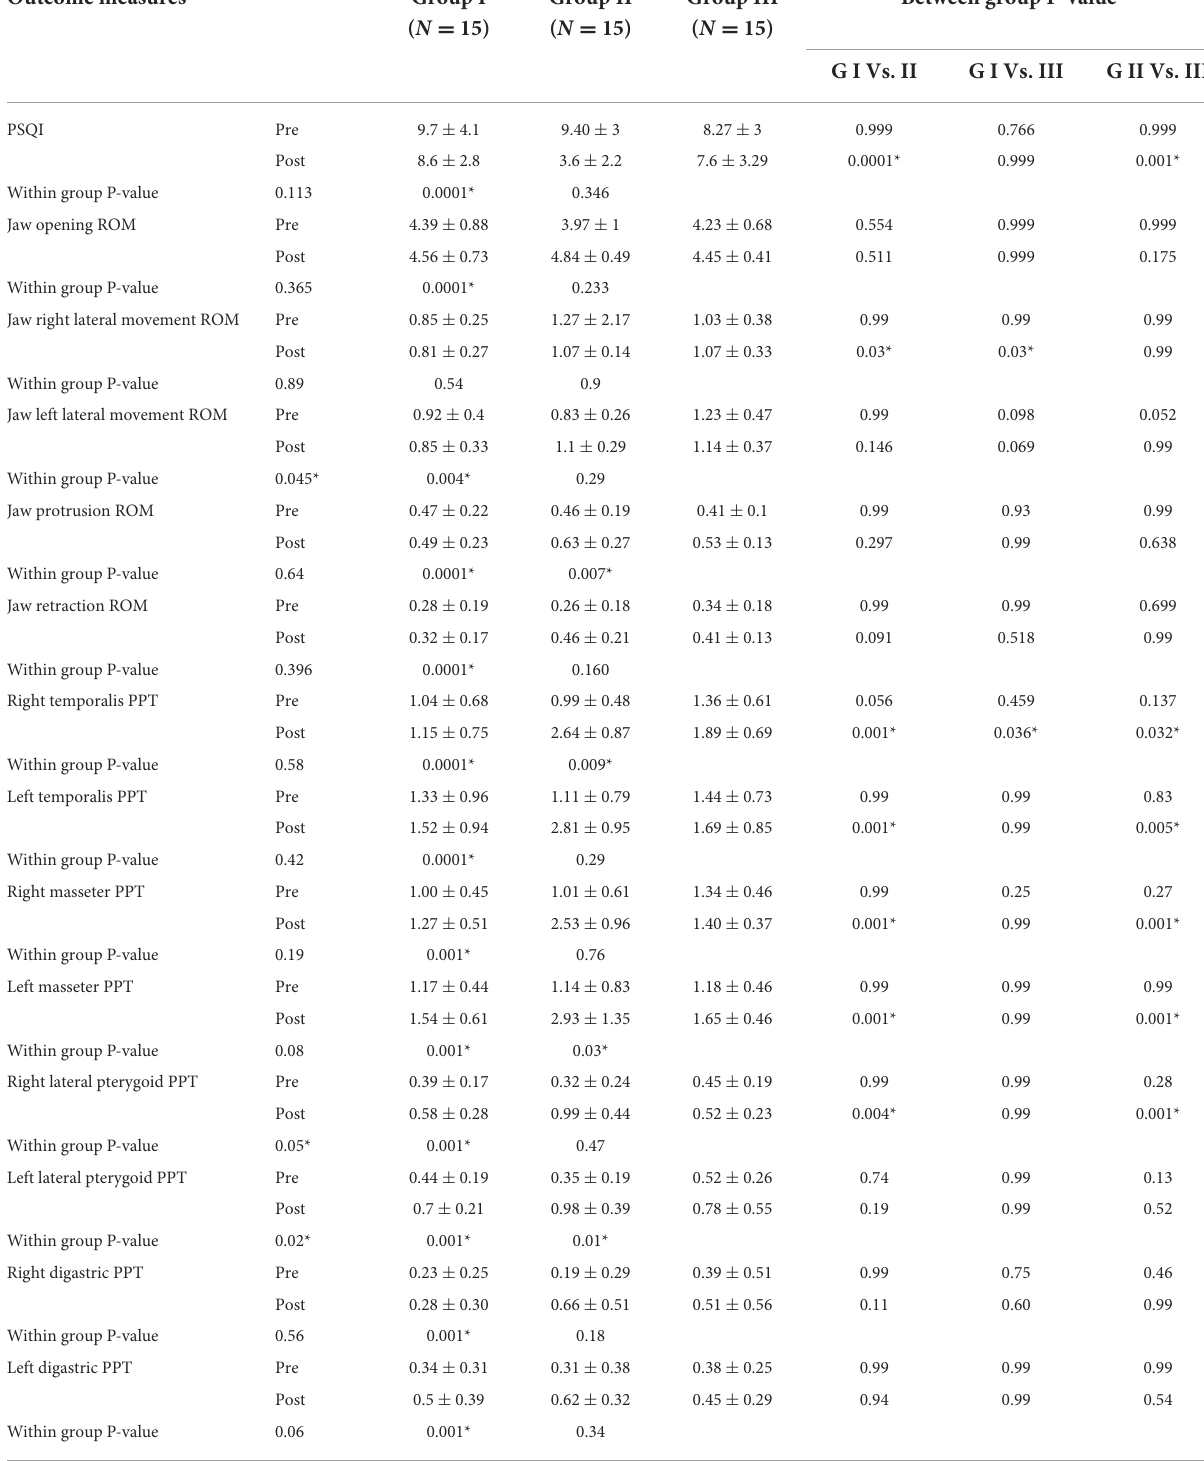
TABLE 3 Mean (SD) of groups and mean (SD) within groups for the tested variables in the “pre” and “post” test conditions. Outcome